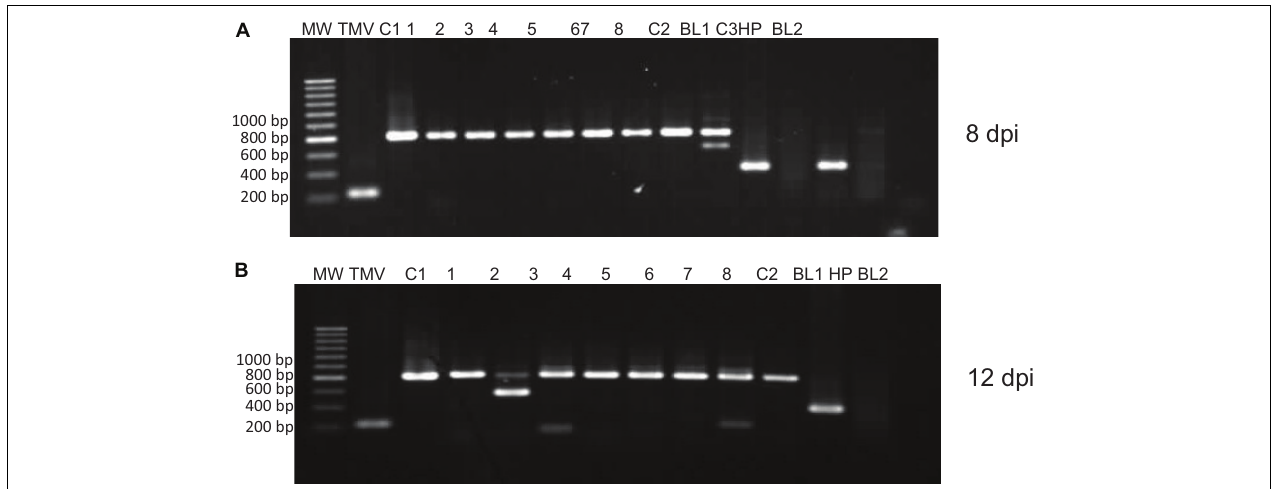
FIGURE 3 | Stability of NPC-2 by IC-RT-PCR. Amplification of an 820-bp fragment, which is the size expected for the recombinant clone, was observed in 100% of the plants infected. MW, hiperladder 200 bp; TMV, empty vector, C1, TMV-PSN-NPC2 clone (820 pb). 1–8, Infected plant, C2, TMV-PSN-EGF clone (397 pb), BL1, negative PCR control; C3, infected plant with TMV-PSN-EGF (IC-RT-PCR positive control). HP: healthy plant, BL2: negative control of IC-RT-PCR. (A) Infected plants to 8 dpi and (B) infected plants to 12